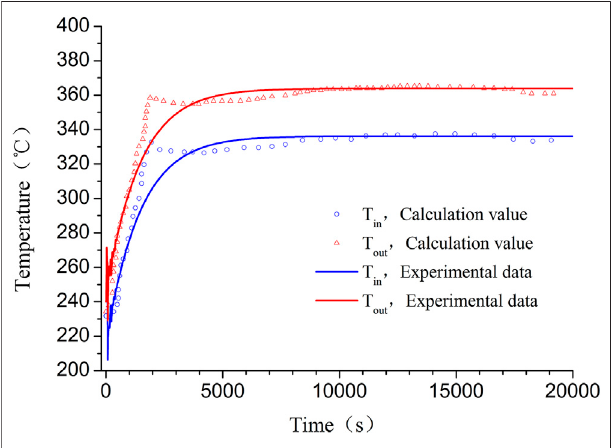
FIGURE 5 | Temperature variation of the inlet and outlet across the